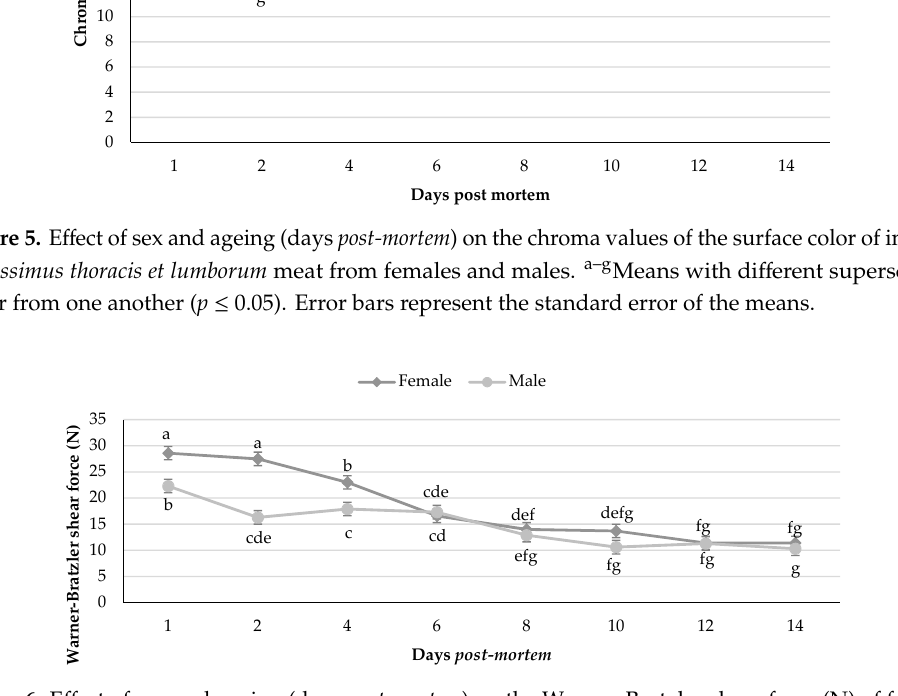
Figure 6. Effect of sex and ageing (days post-mortem ) on the Warner–Bratzler shear force (N) of female and male impala longissimus thoracis et lumborum muscles. a–h Means with different superscripts differ from one another ( p ≤ 0.05). Error bars represent the standard error of the means.